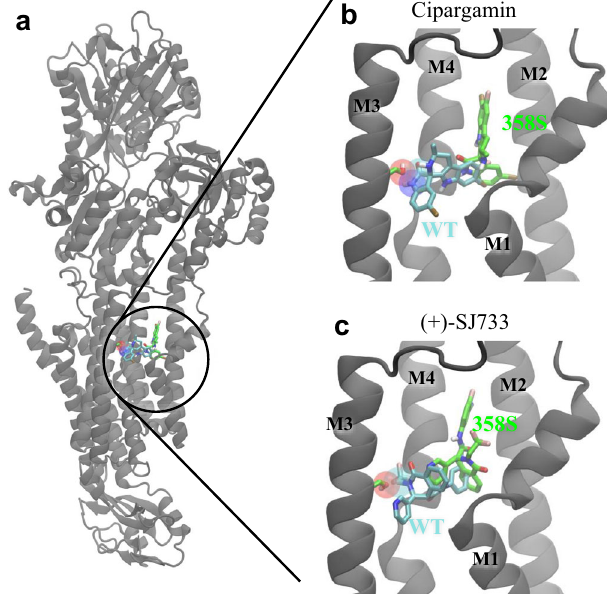
Fig. 5 | Binding sites proximal to PfATP4 residue 358 predicted by molecular dockingtotheOpenSourcestructure.a Thelocationofthelowestenergyposes foundforcipargamindockedagainstWT(cyan)andG358Smutant(green)PfATP4, in relation to the entire protein ’ s structure. The side chain of S358 is also shown in greenatitspositiononM3.Closeupsofthebindinglocationsof( b )cipargaminand ( c ) (+)-SJ733 are shown, with the compounds ’ carbon atoms in the lowest energy pose shown in cyan for WT PfATP4 and with green for G358S mutant PfATP4. The space occupied by the atoms in the WT binding pose that sterically clash with the S358 side chain are highlighted by transparent balls.